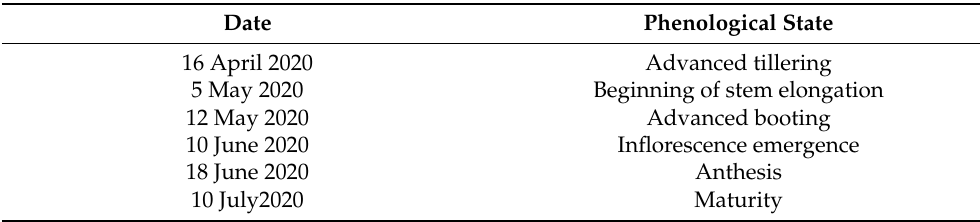
Table 3. Flight missions date (dd mm yyyy) and relative phenological